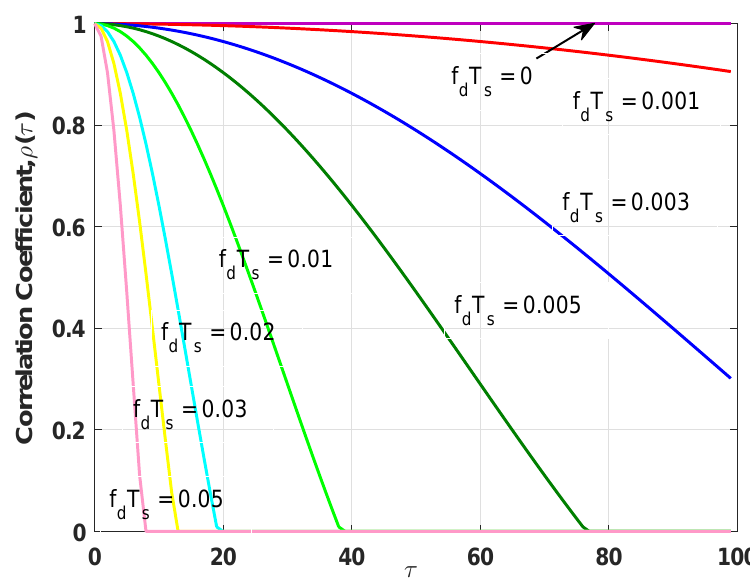
Figure 3. The correlation coefficient for various f d T s